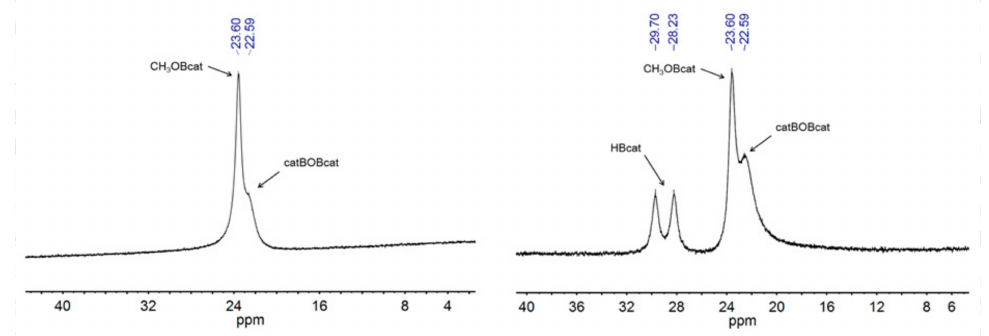
Figure 2. 11 B NMR spectra for the interactions of the nickel complexes (0.01 mmol) with HBcat (0.3 mmol) in benzene- d 6 (0.5 mL) under a CO 2 atmosphere at room temperature. The spectra were